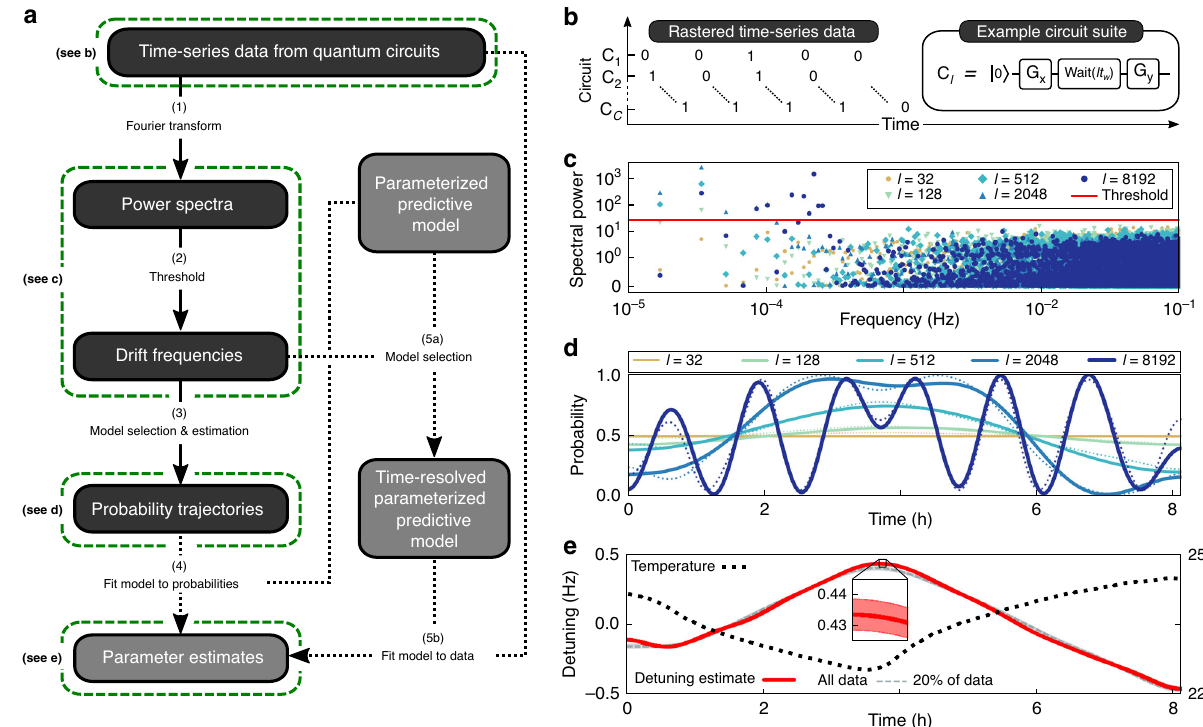
Fig. 1 Diagnosing time-dependent errors in a quantum information processor. a A fl owchart of our methodology for detecting and quantifying drift in a QIP, using time-series data from quantum circuits. The core steps (1 – 3) detect instability, identify the dominant frequencies in any drift, and estimate the circuit outcome probabilities over time. They can be applied to data from any set of quantum circuits, including data collected primarily for other purposes. Additional steps (4 and/or 5) estimate time-varying parameters (e.g., error rates) whenever a time-independent parameterized model is provided for predicting circuit outcomes. Such a model is readily available whenever the circuits are from an existing characterization technique, such as Ramsey spectroscopy or gate set tomography. b An example of circuits on which this technique can be implemented — Ramsey circuits with a variable wait time lt w — as well as an illustration of data obtained by “ rastering ” (each circuit is performed once in sequence and this sequence is repeated N times). c – e Results from performing these Ramsey circuits on a 171 Yb + ion qubit ( l = 1, 2, 4, … , 8192, t w ≈ 400 μ s, N = 6000). c The power spectra observed in this experiment for selected values of l . Frequencies with power above the threshold almost certainly appear in the true time-dependent circuit probabilities, p t ). d Estimates of the probability trajectories (unbroken lines are estimates from applying step 3 of the fl owchart; dotted lines are the probabilities l ( implied by the time-resolved detuning estimate shown in e ). e The standard Ramsey model p l ð t Þ ¼ A þ B sin ð 2 π lt w Ω Þ , where Ω is the qubit detuning, is promoted to a time-resolved parameterized model (step 5a) and fi t to the data (step 5b) using maximum likelihood estimation, resulting in a time-resolved detuning estimate (red unbroken line). The detuning is strongly correlated with ambient laboratory temperature (black dotted line), suggesting a causal relationship that is supported by further experiments (see the main text). The detuning can still be estimated to high precision using only 20% of the data (gray dashed line), which demonstrates that our techniques could be used for high precision, targeted drift tracking while also running application circuits. The shaded areas are 2 σ (~95%) con fi dence